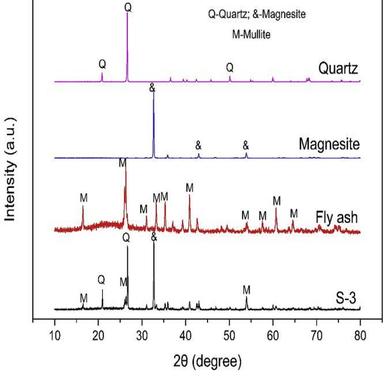
XRD patterns of the raw materials.